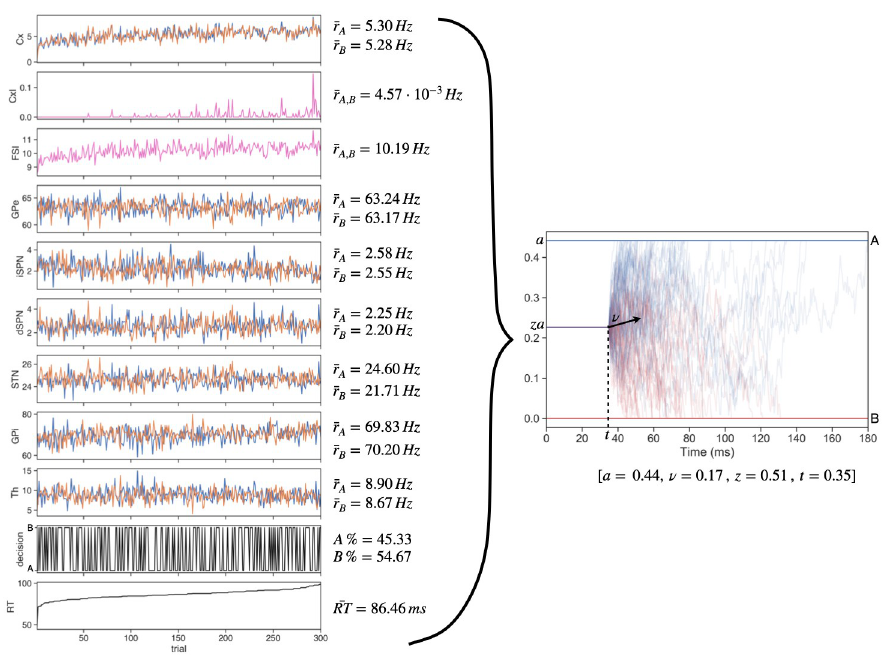
Fig 4. Example of data generated for a single network configuration. The left panels show the the average pre- decision firing rates, decision outcomes (1 = A, 0 = B), and reaction times across all 300 trials of a single network instance. Mean values are reported next to each plot. From the network behavior a single set of DDM parameters was fit; these parameter values are listed in the right panel, which shows a collection of DDM runs with these parameters. These values represent one sample in the distributions shown in Fig 5. Trials are sorted in order of increasing reaction